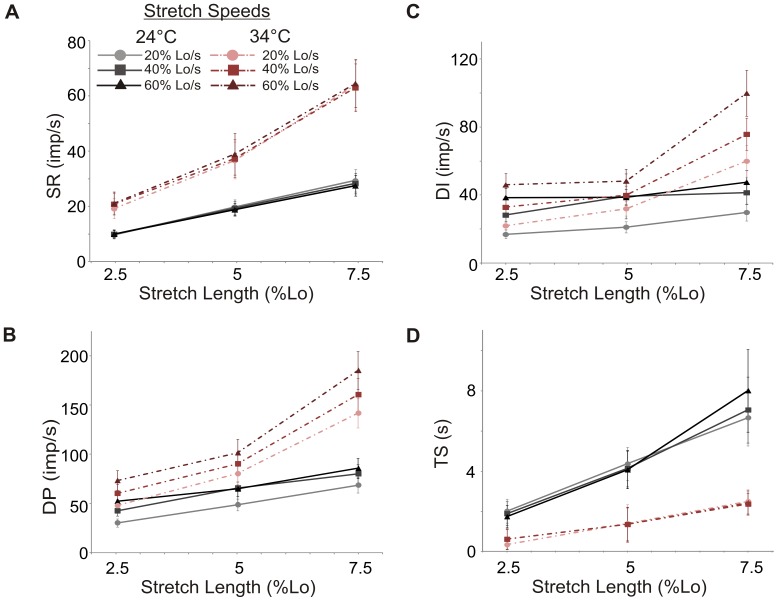
Effect of stretch length, speed, and temperature on spindle afferent firing.Response of 4 ramp-and-hold stretch variables to the three levels of stretch length (x axis) and 3 speeds of stretch as indicated in the legend atop A. Stretch speeds are denoted by separate lines at 24°C (solid black) and at 34°C (dashed colored). A. Static response (SR) B. Dynamic peak (DP) C. Dynamic index (DI) D. Time silenced (TS). Error bars indicate a 95% confidence interval.